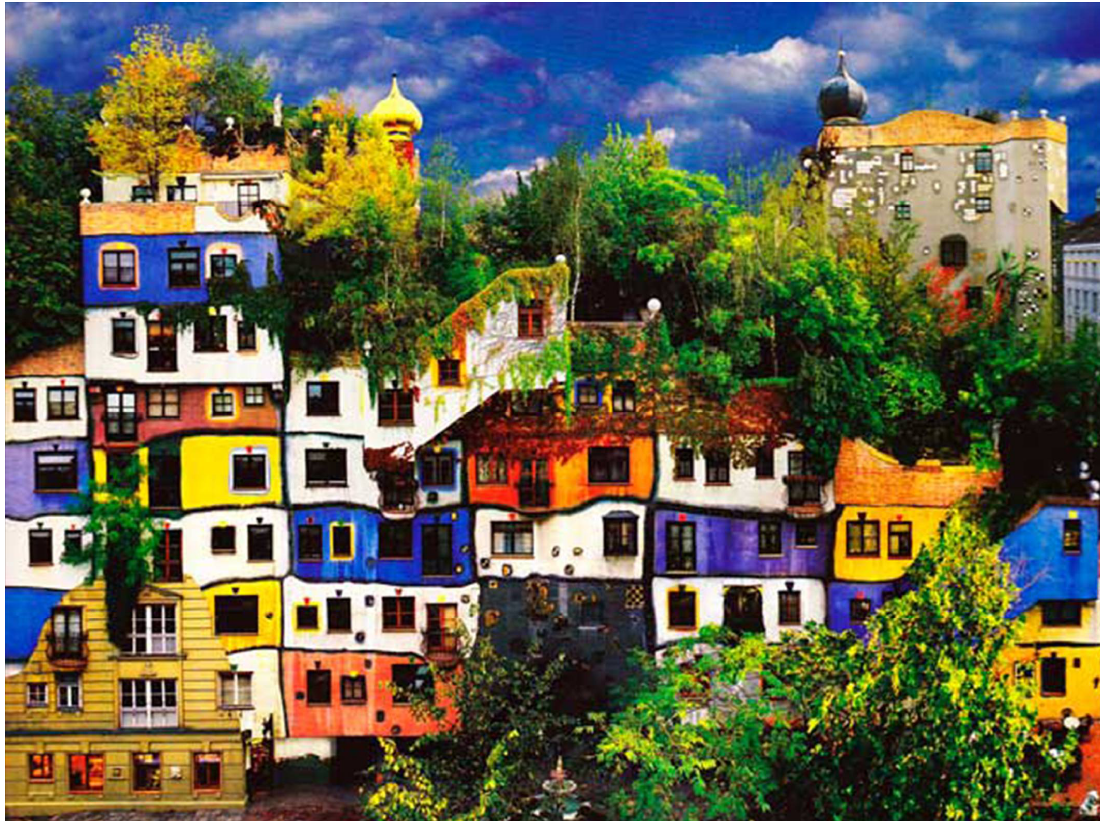
Figure 5. Façade of the Hundertwasserhaus.